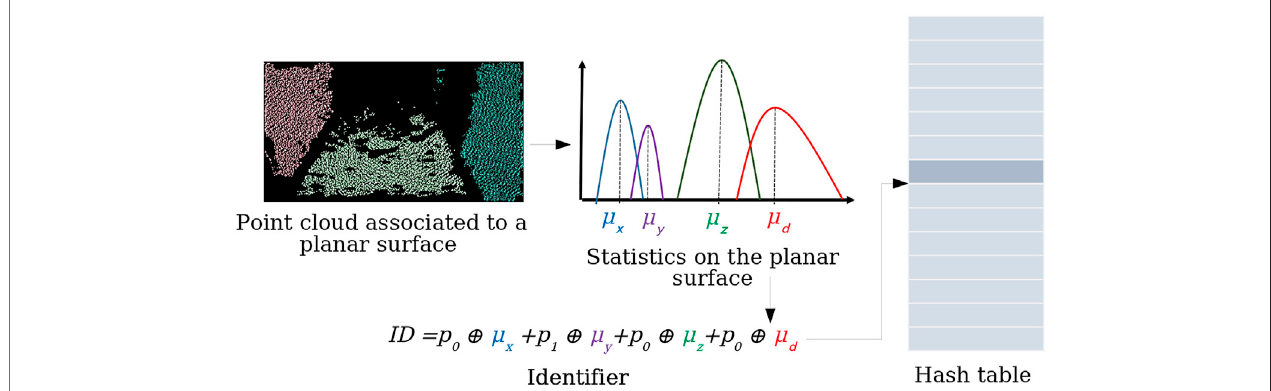
FIGURE 3 | Illustration of the hash table. On the left: a point cloud segmented into three planar surfaces. For each planar surface, four histograms are computed. The statistics are used to build an identi fi er that is used as a key to address the hash table.